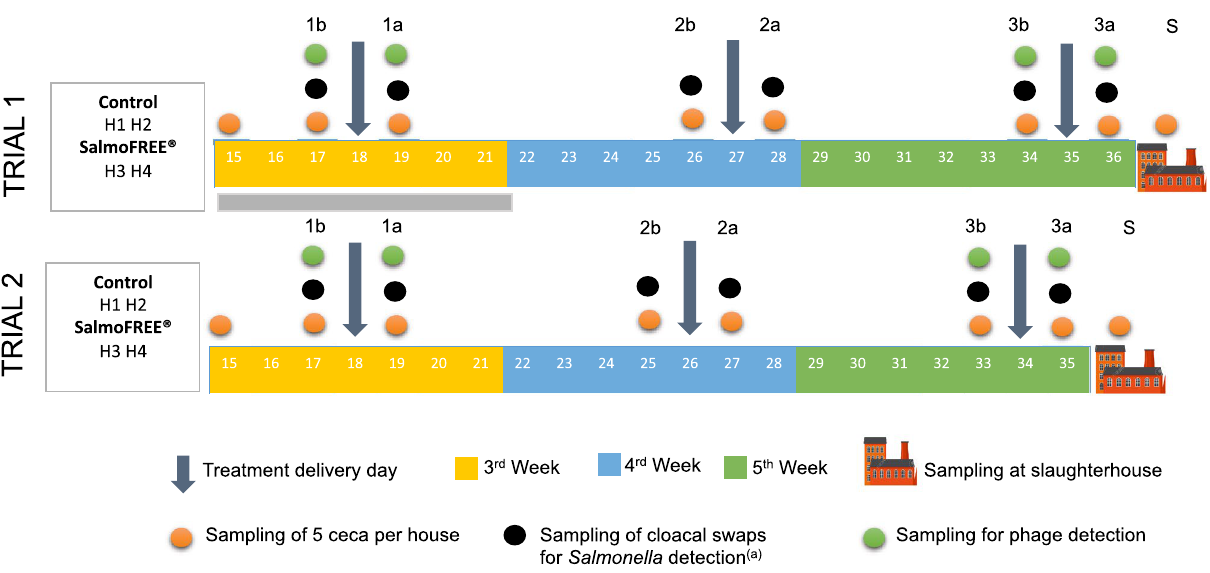
Figure 1. Experimental design and samples taken through the production cycle of trials 1 and 2. The number in the colored boxes corresponds to the cycle day. The color of the boxes corresponds to the week of the cycle (3rd to 5th). The last day corresponds to the slaughter date. Down-pointing arrows indicate the days where the treatment was administered (phage or control). The sampling days are also indicated with colored spheres. The nomenclature of the sampling point corresponds to the dose followed by the letter b (before) or a (after) and at the slaughterhouse (S). The farmhouse labels are H1 and H2 for controls and H3 and H4 for treatments. (a) Total number of individual cloacal swaps sampled were 5 and 10 for Trial 1 and Trial 2 respectively. This figure was made using PowerPoint for Mac v 16.5 (https:// www. micro soft. com/ en- ww/ micro soft- 365/ mac/ micro soft- 365- for-